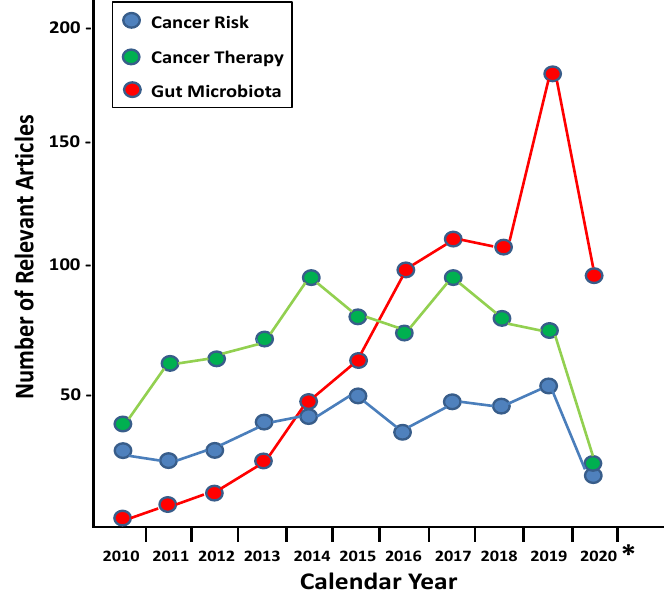
Figure 1. Record of publications over the last 10 years on the direct e ff ects of antibiotic exposure on cancer risk (blue) and therapy outcomes (green), compared to microbiota-mediated studies (in red). Information for 2020 only includes data for the first six months of the year ( *